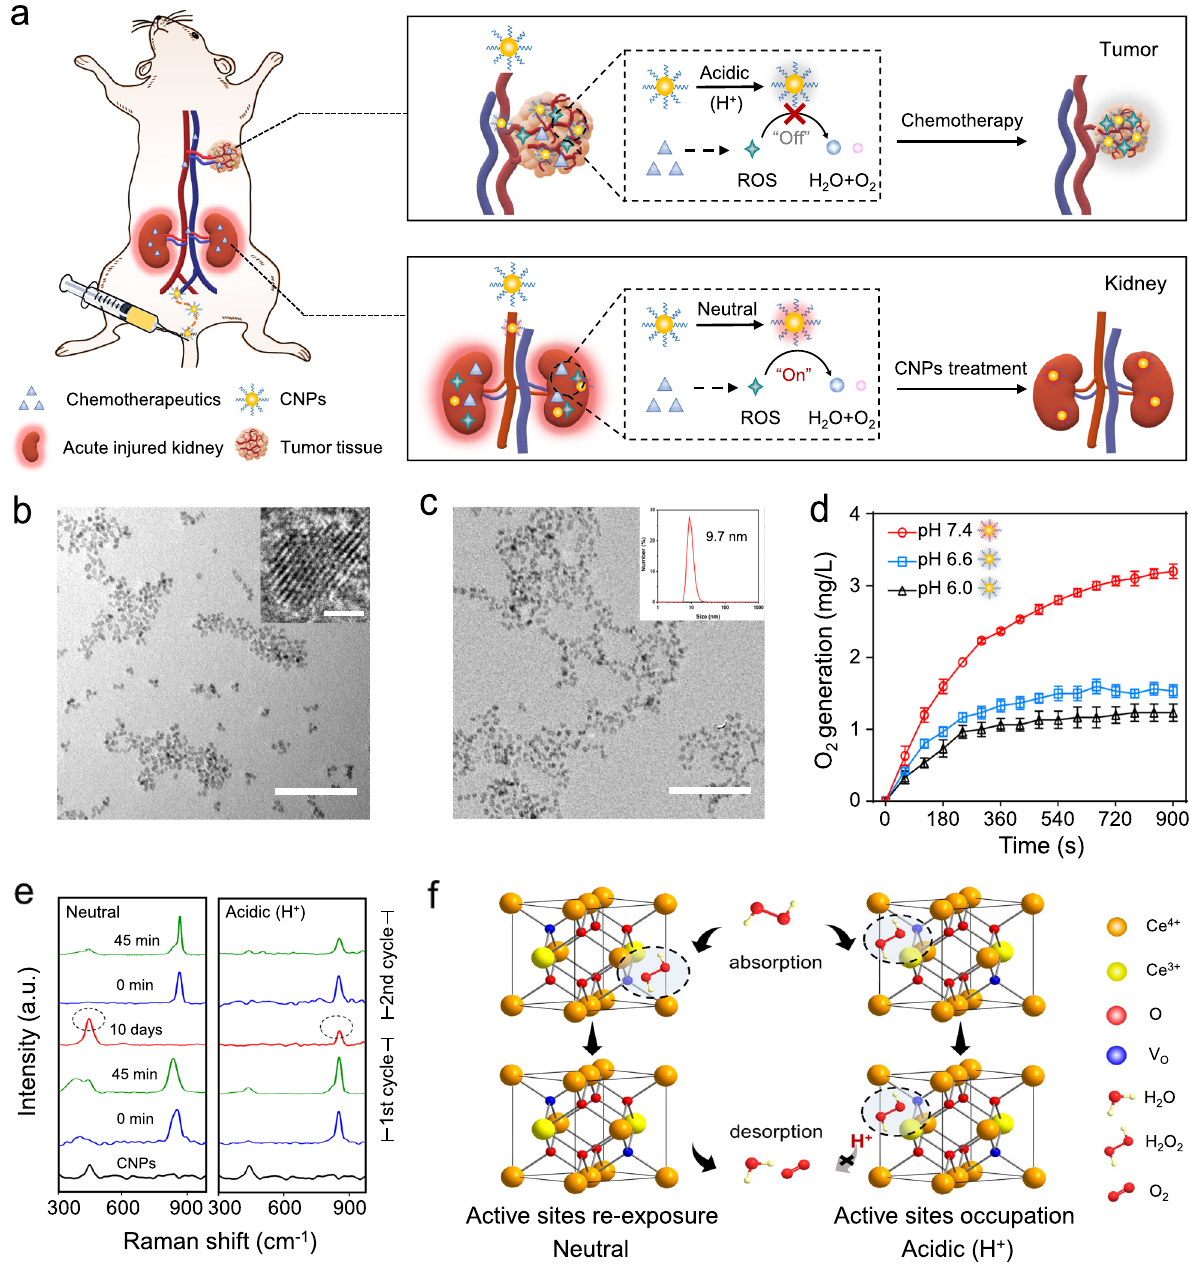
catalytic activity tunable CNPs with context-dependent cytoprotective activities for AKI prevention during chemotherapy. High-concentration